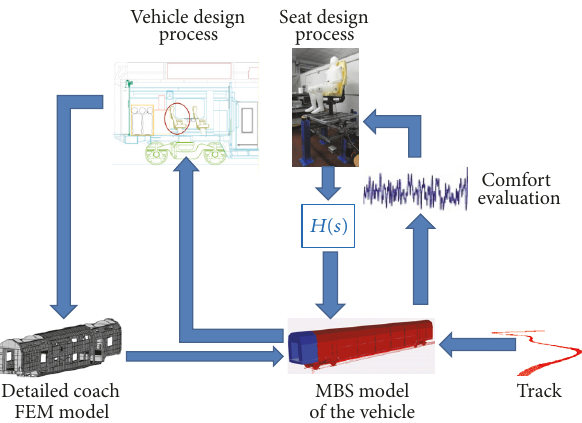
Figure 1: Scheme describing the function of the vehicle numerical model inside the design